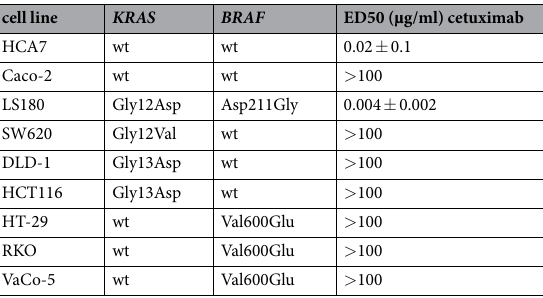
Table 1. KRAS and BRAF mutation status and ED50 values for cetuximab ( μ g/ml) of the studied CRC cell lines. Wt, wild-type. Mean + / − SD is